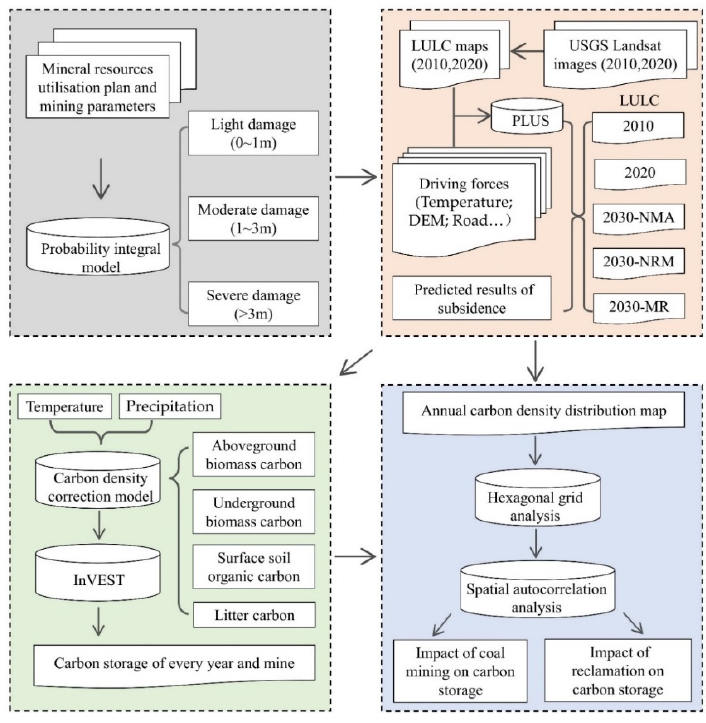
Figure 3. Research